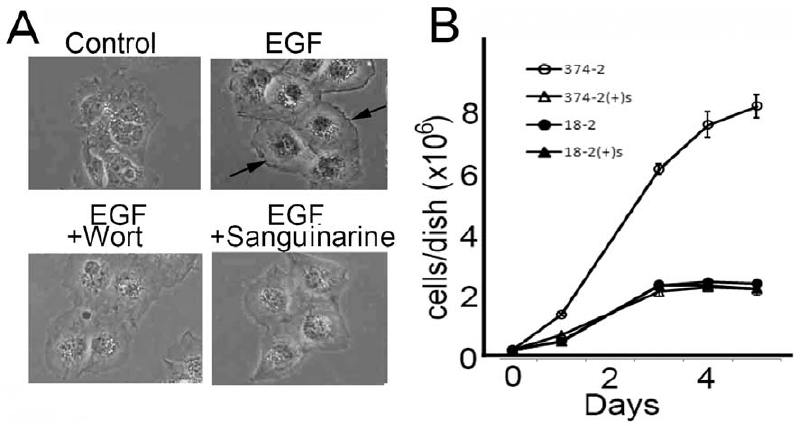
Figure 7. Sanguinarine inhibits membrane ruffling of Cos7 cells. A, Cos7 cells were treated with sanguinarine (2 m M) or wortmannin (100 nM) 15 min prior to EGF (100 ng/ml) stimulation for 5 min. After fixation with formaldehyde, cells were observed. The arrows indicate membrane ruffles. B, 18-2 cells or SWAP-70-374-2 cells were seeded on 6-cm dishes at a cell density of 1 6 10 5 cells in the dish. Cells were grown in the presence or absence of sanguinarine (0.8 m M) with medium change on every other day. Cell numbers were monitored. Open circles: SWAP-70-374-2 cells without sanguinarine; closed circles: 18-2 cells without sanguinarine; open triangles: SWAP-70-374-2 cells with sanguinarine, closed triangles: 18- 2 cells with sanguinarine. Error bars indicate standard deviation.